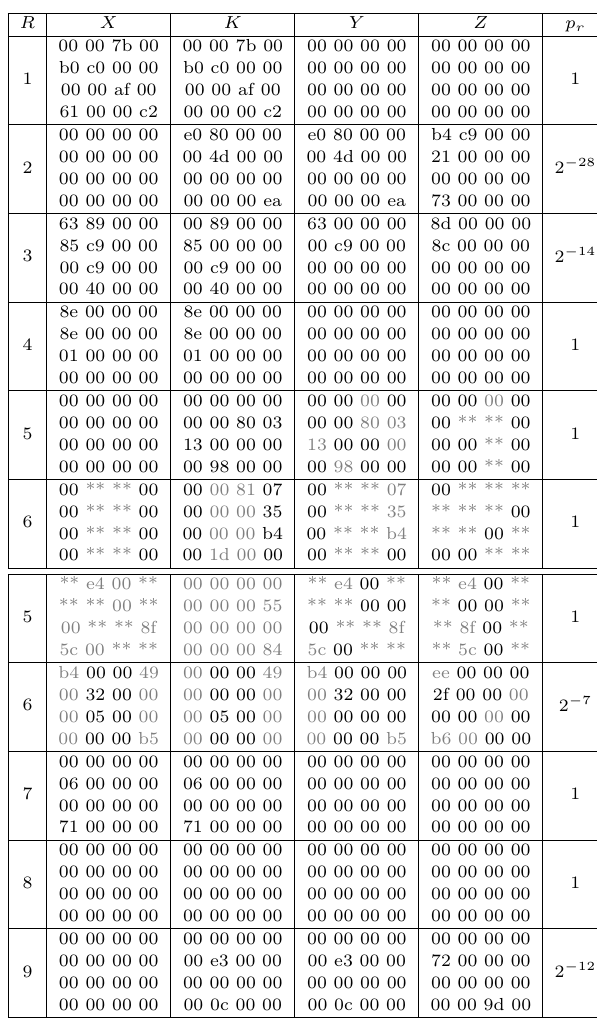
Table 8: 9-round distinguisher of